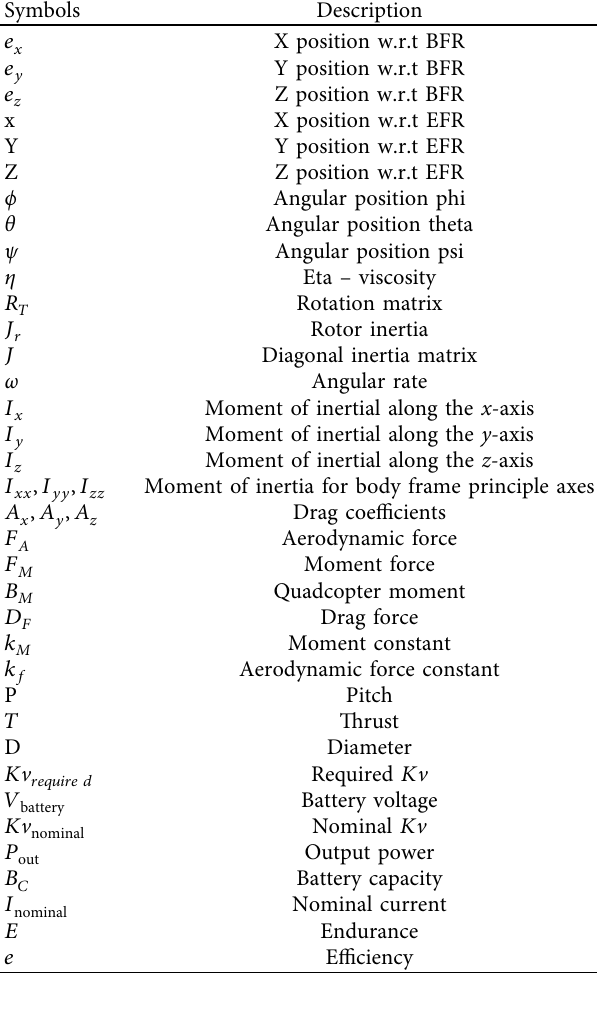
Table 2: List of